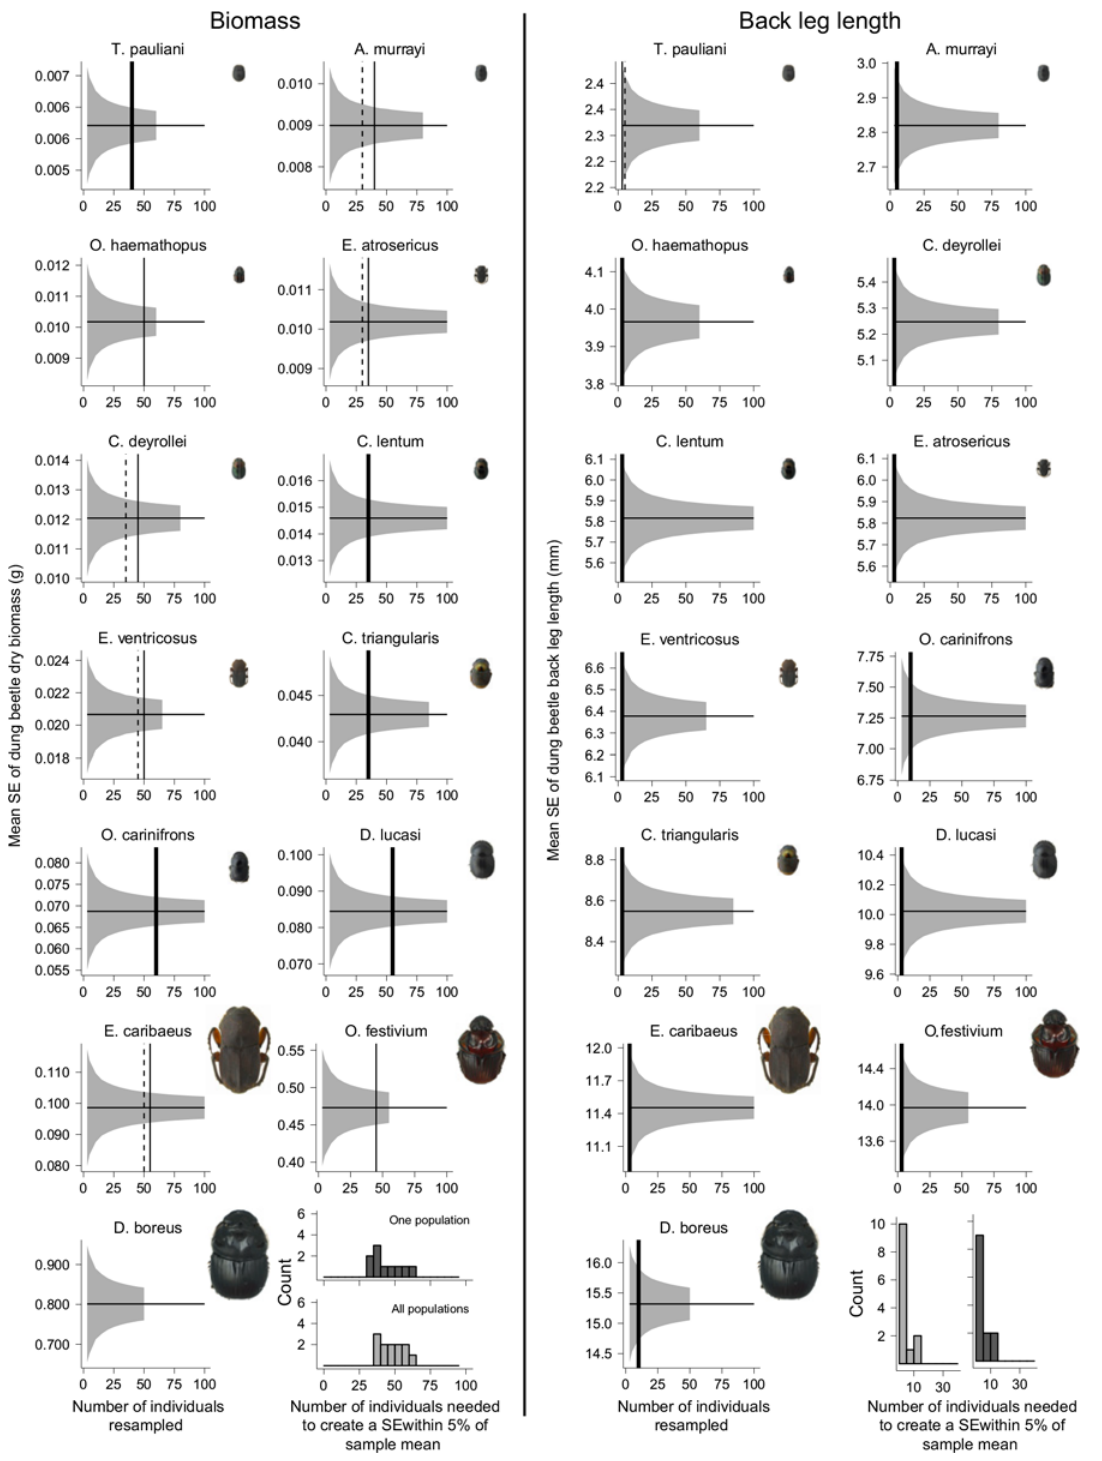
Fig 2. Resampling of dung beetle body mass and back leg length. Total population mean (solid horizontal black lines; calculated using all individuals from each species, n = 51 – 229) and mean standard error (grey ribbons; calculated using resampled data from focal species, n = 13, collected from all sampling locations) of dung beetle dry body mass (left panel) and back leg length (right panel) with species photographs. Photographs are scaled to each other; smallest species, Trichillum pauliani , length: 5.5mm; largest species, Dichotomius boreus , length: 24mm length. Species trait values were resampled